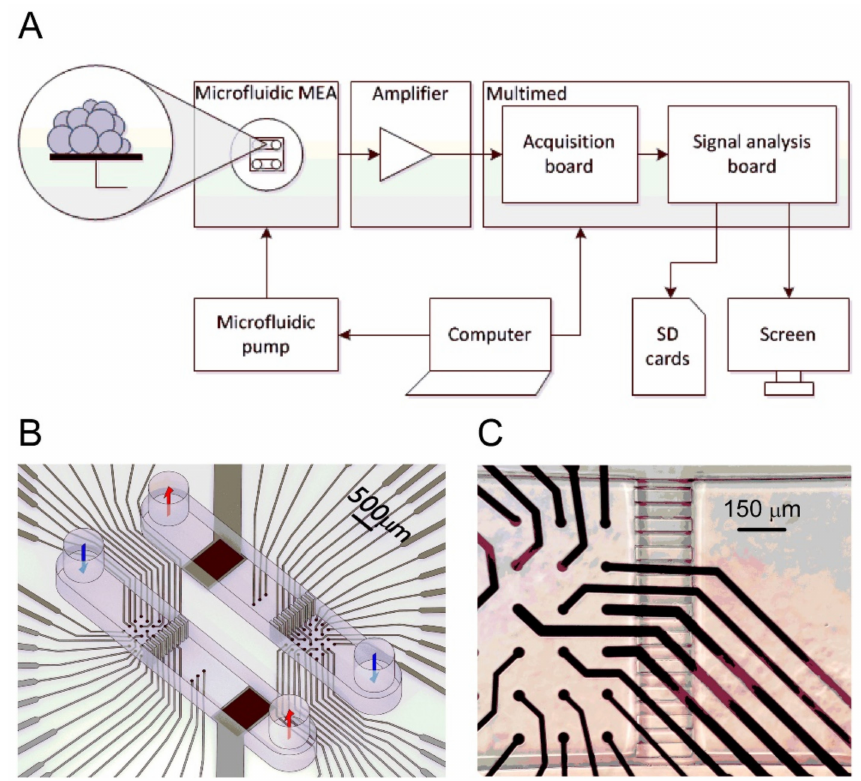
Figure 7. Reproduced with permission from Ref. [146] ( A ) Using a microfluidic pump, perfusion of islet seeds on the microfluidic MEAs occurs. Data of electrical signals are collected, magnified, processed, and analyzed by Multimed acquisition and analysis board. Data that are raw and processed are stored on separate secure digital (SD) cards. ( B ) Microfluidic MEA setup, consisting of two identical chambers in SU-8. Within the chambers, they are further divided into two parts that are separated by a barrier. The barrier is composed of small channels with dimensions of 50 µ M. One side has 26 platinum black electrodes with a diameter of 30 µ m and a distance of 150 µ m between each. The other has one reference electrode and three control electrodes. ( C ) Closeup image of the microfluidic MEA chamber located on the left. In the middle of the image, there is a recording chamber. On the right, there is the reference chamber, outlet, that is separated by the